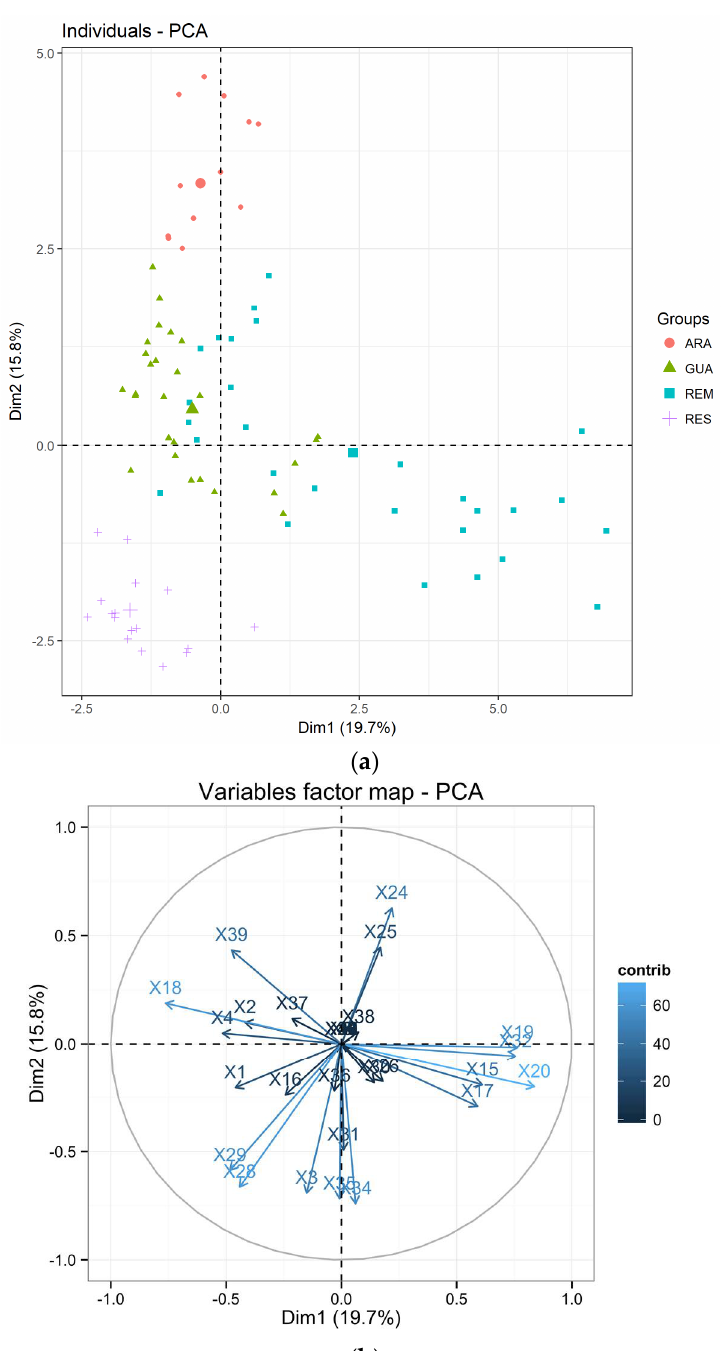
Figure 2. ( a ) PCA of Laguncularia racemosa individuals: RES—plants from restored area in Mauá Beach; REM—remnant plants in Mauá Beach; GUA—ESEC Guanabara; ARA—Araçá Bay. ( b ) Graphic showing the contribution of each ISSR loci in the PCA of L. racemosa individuals. The legend shows a gradient color map from blue (no contribution) to red (high contribution).